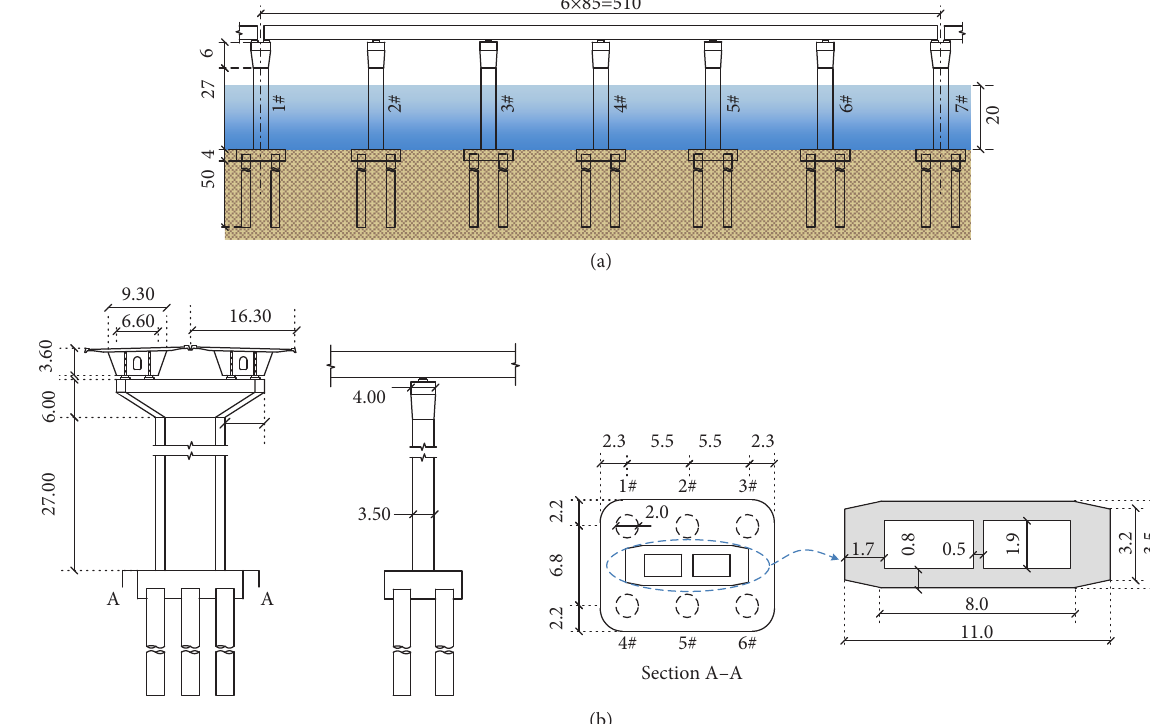
Figure 1: Schematic diagram of bridge and the main sections (unit: m): (a) elevation view and (b) schematic diagram of component dimensions.